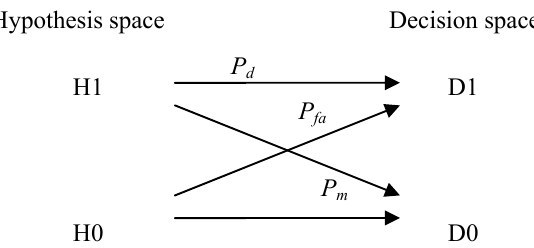
Figure 4. Binary hypothesis of a real situation: H1: train diverted to siding, H0: train has remained on main track. Possible detector decisions: D1: turnout detected, D0: turnout not